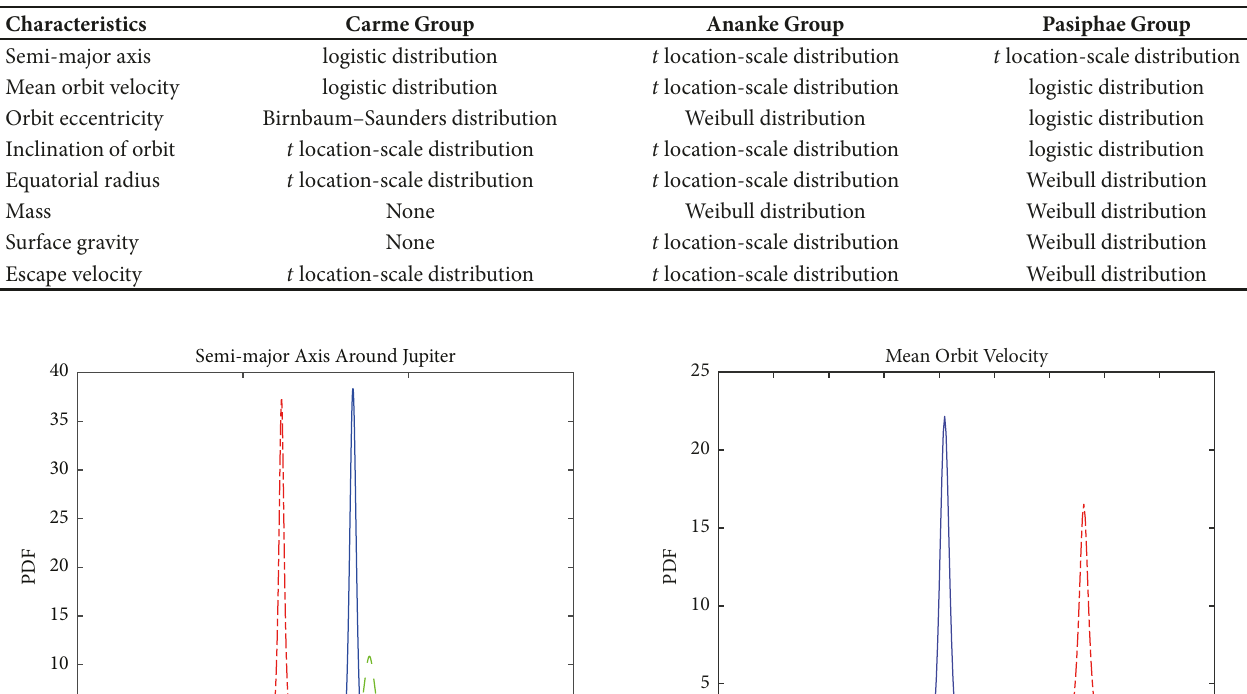
Table 5: Distribution inference summary.